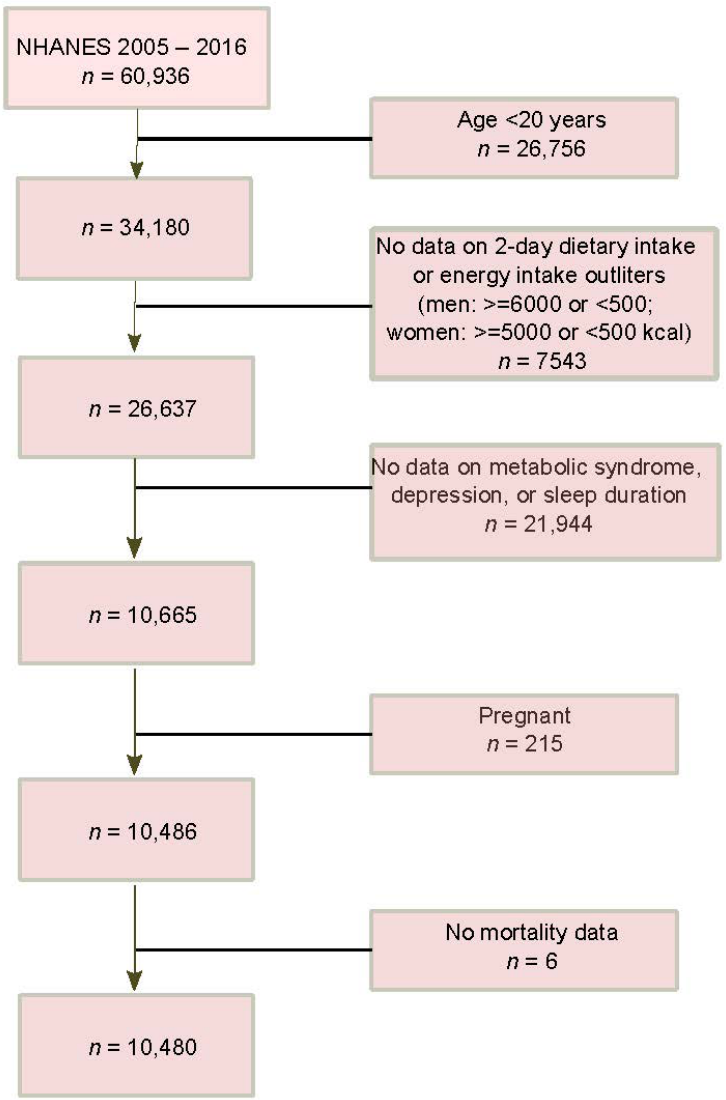
Figure 1. Sample